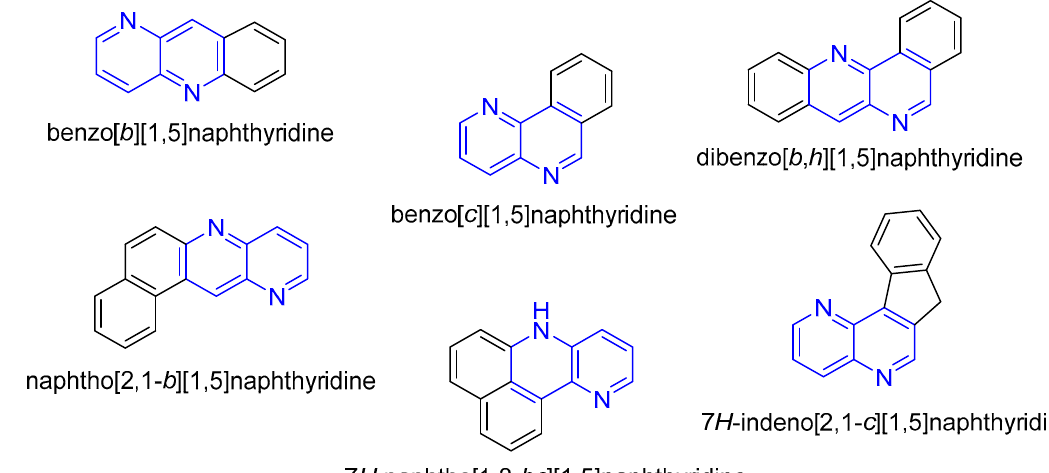
Figure 2. Examples of fused 1,5-naphthyridines with carbocycles.